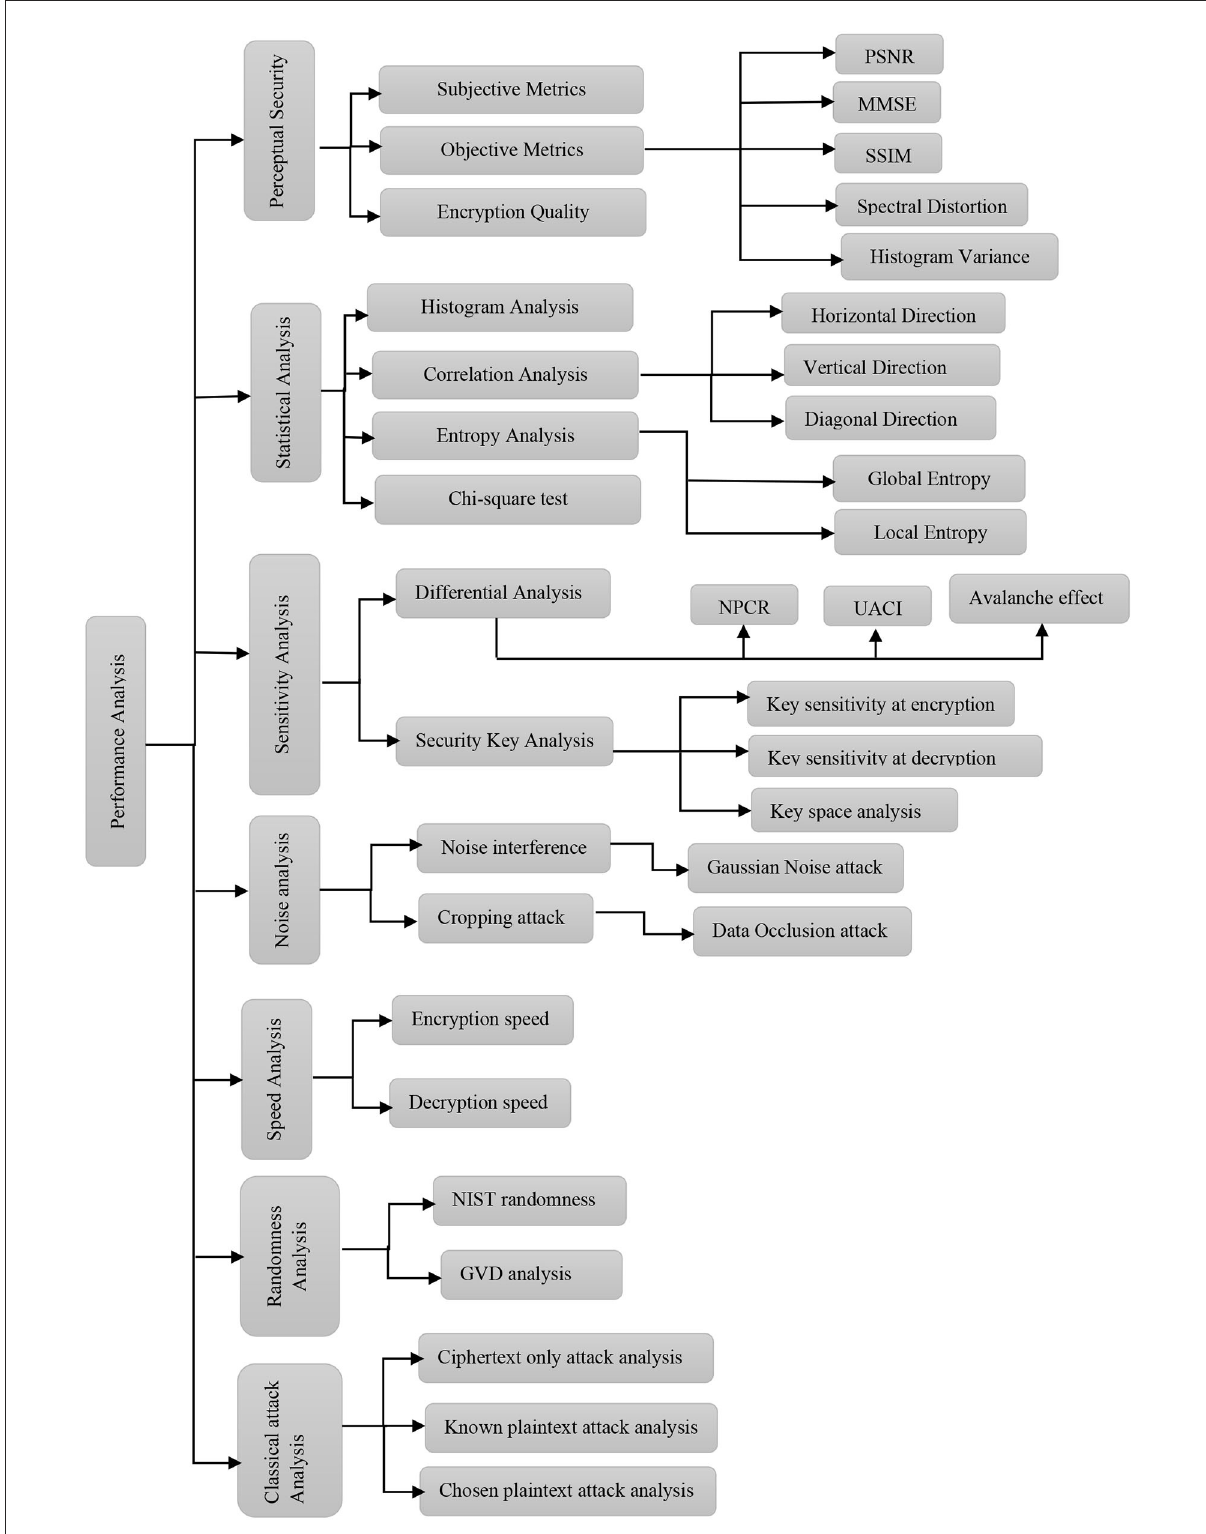
FIGURE4 Performance requirements of image encryption